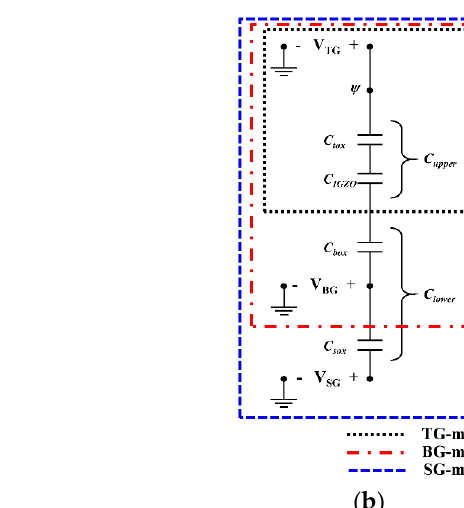
Figure 6. Transfer characteristic curves of triple-gate a-IGZO TFTs operating in the ( a ) TG, ( b ) BG, and ( c ) SG modes. The insets show the output characteristic curves corresponding to each operating mode.